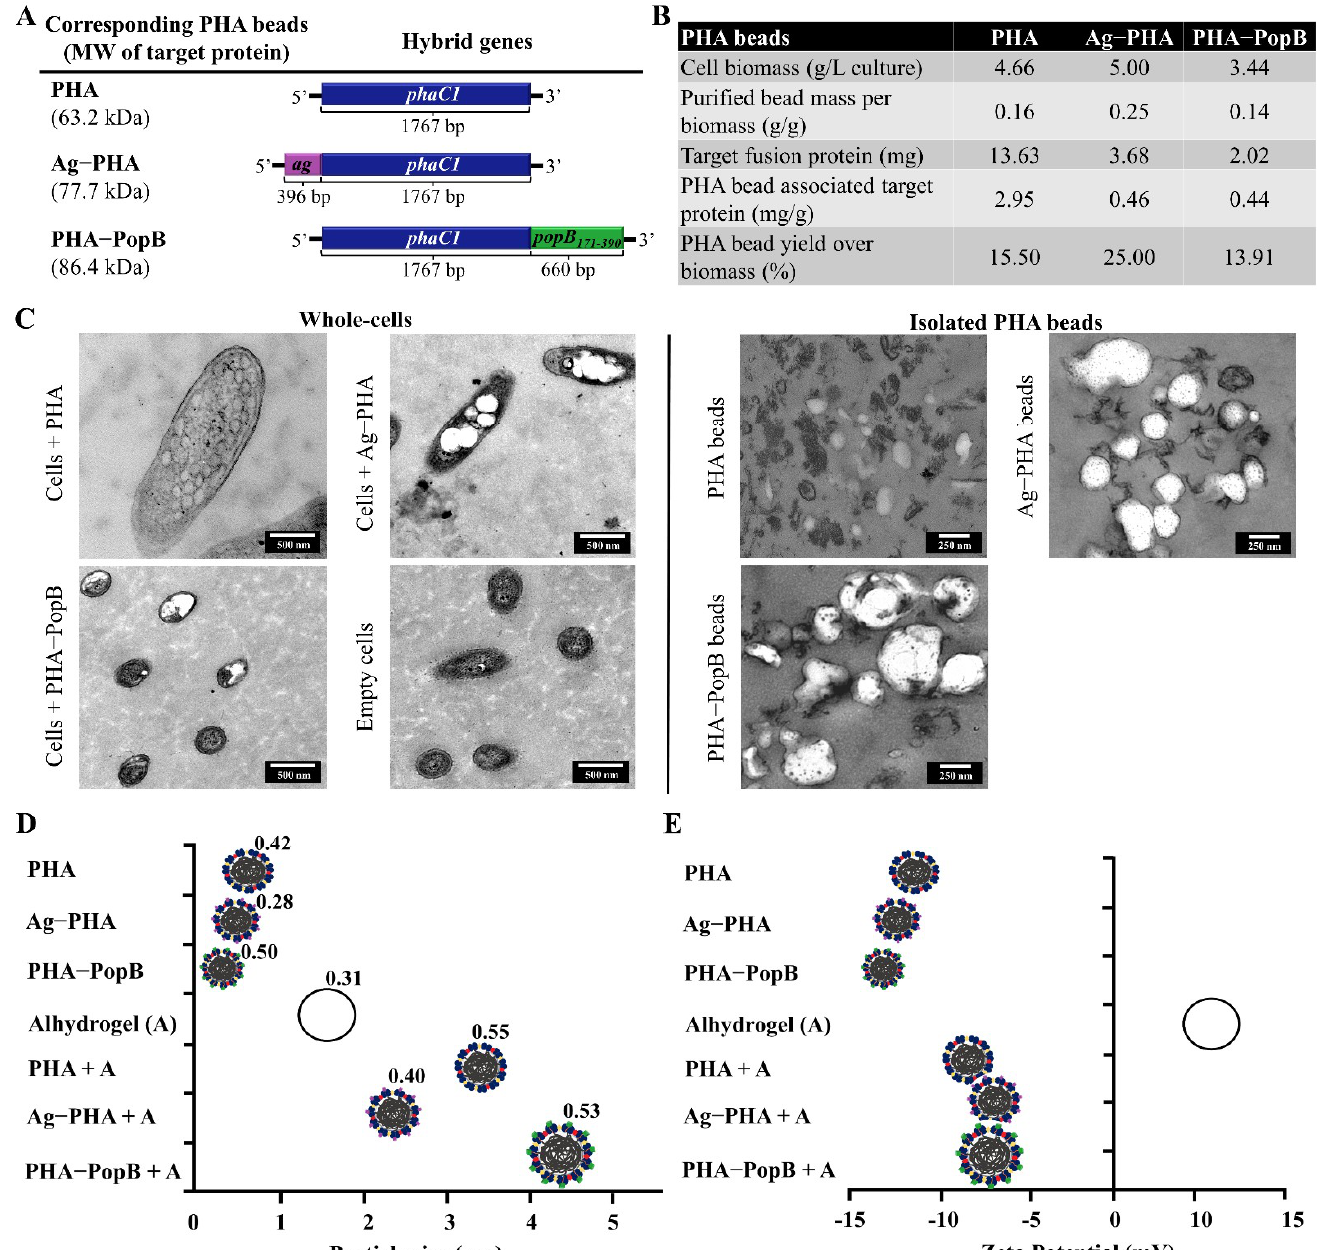
Figure 2. Production and biophysical characterization of PHA beads. ( A ) Schematic representation of hybrid genes encoding fusion proteins for the production of PHA, Ag‐PHA and PHA‐PopB beads in P. aeruginosa PAO1ΔCΔ8ΔF strain. MW (Molecular weight). phaC1 is the PHA synthase gene. ( B ) Table showing PHA beads composition and yield data. ( C ) TEM images for accumulation and size analysis of PHA beads in whole‐cell and isolated PHA beads fractions. ( D ) Size of PHA beads before and after formulation with Alhydrogel adjuvant. Polydispersity indices are shown above the beads. ( E ) Zeta potential of PHA beads before and after formulation with Alhydrogel adjuvant. The particle size and zeta‐potential of each PHA beads were measured three times by Zetasizer Nano ZS. Each data point of measurement represents the mean ± SEM. The values are shown in Table S3.